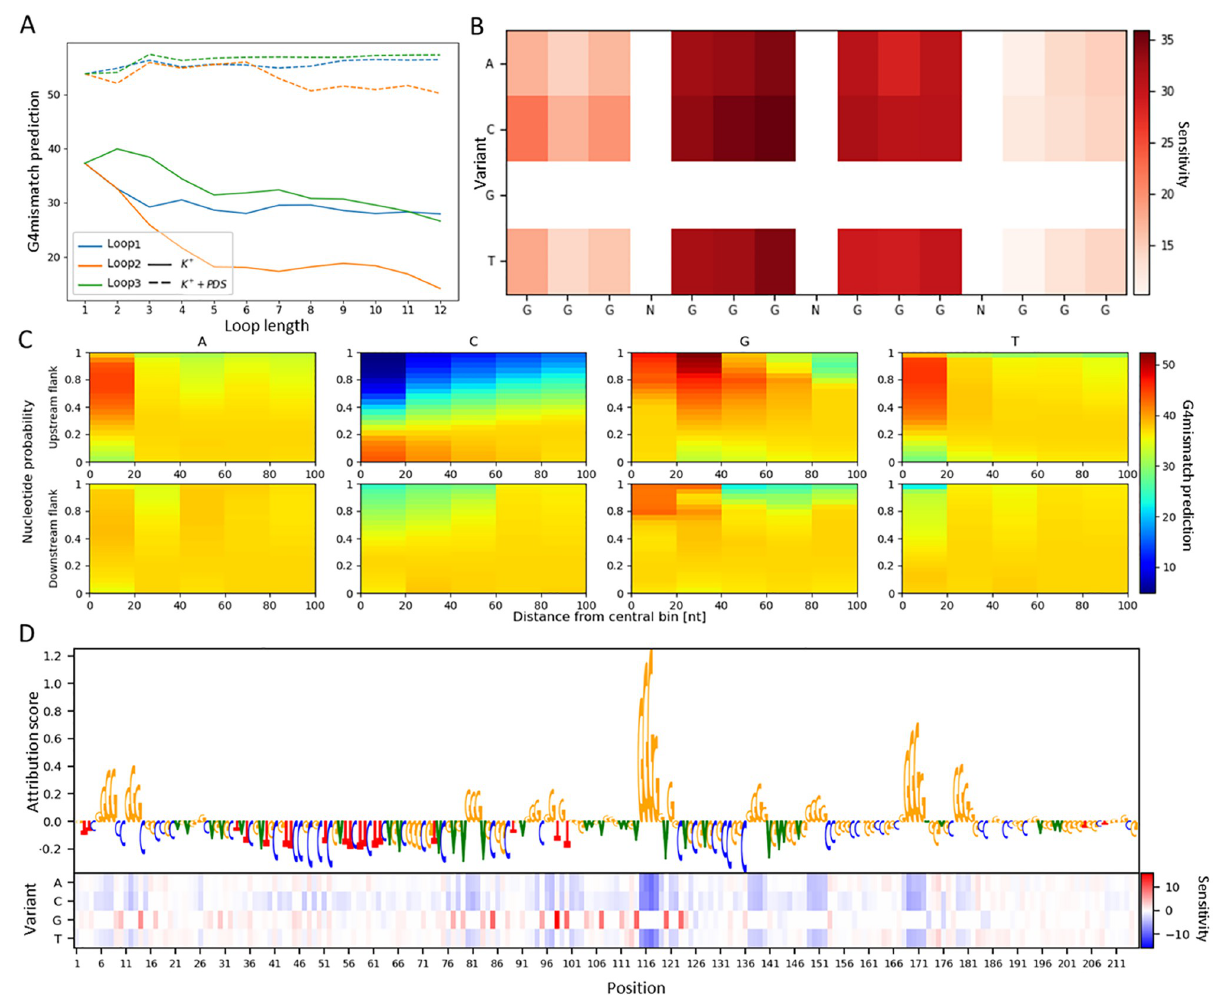
Fig 7. Interpreting G4mismatch. (A) Loop length effect on mismatch-score prediction. For the canonical G4 GGGNGGGNGGGNGGG, we varied the length of each loop separately, and predicted the mismatch score using both the K + and K + +PDS models. (B) Effect of mismatch in the G-tracts on K + model predictions. For the canonical G4 GGGNGGGNGGGNGGG, we mutated each nucleotide in the G-tracts separately to all other nucleotides, and calculated the change in the predicted mismatch score. (C) Effect of nucleotide composition in the flanking sequences on K + model predictions. For the canonical G4 of the form GGGNGGGNGGGNGGG, we varied the probability of each nucleotide at a time, while assigning uniform probabilities to the other three nucleotides, in 20nt-long regions away from the central bin. We predicted the mismatch score for each such variant, on both the upstream and downstream flanks, separately. (d) The mutation map shows the sensitivity of the K + model to mutations and the corresponding attributions report the importance of a given feature to the model’s